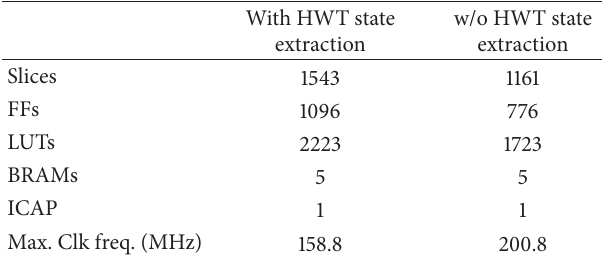
Table 3: ICAP-DMA—synthesis results. Table 4: HWT wrapper—synthesis